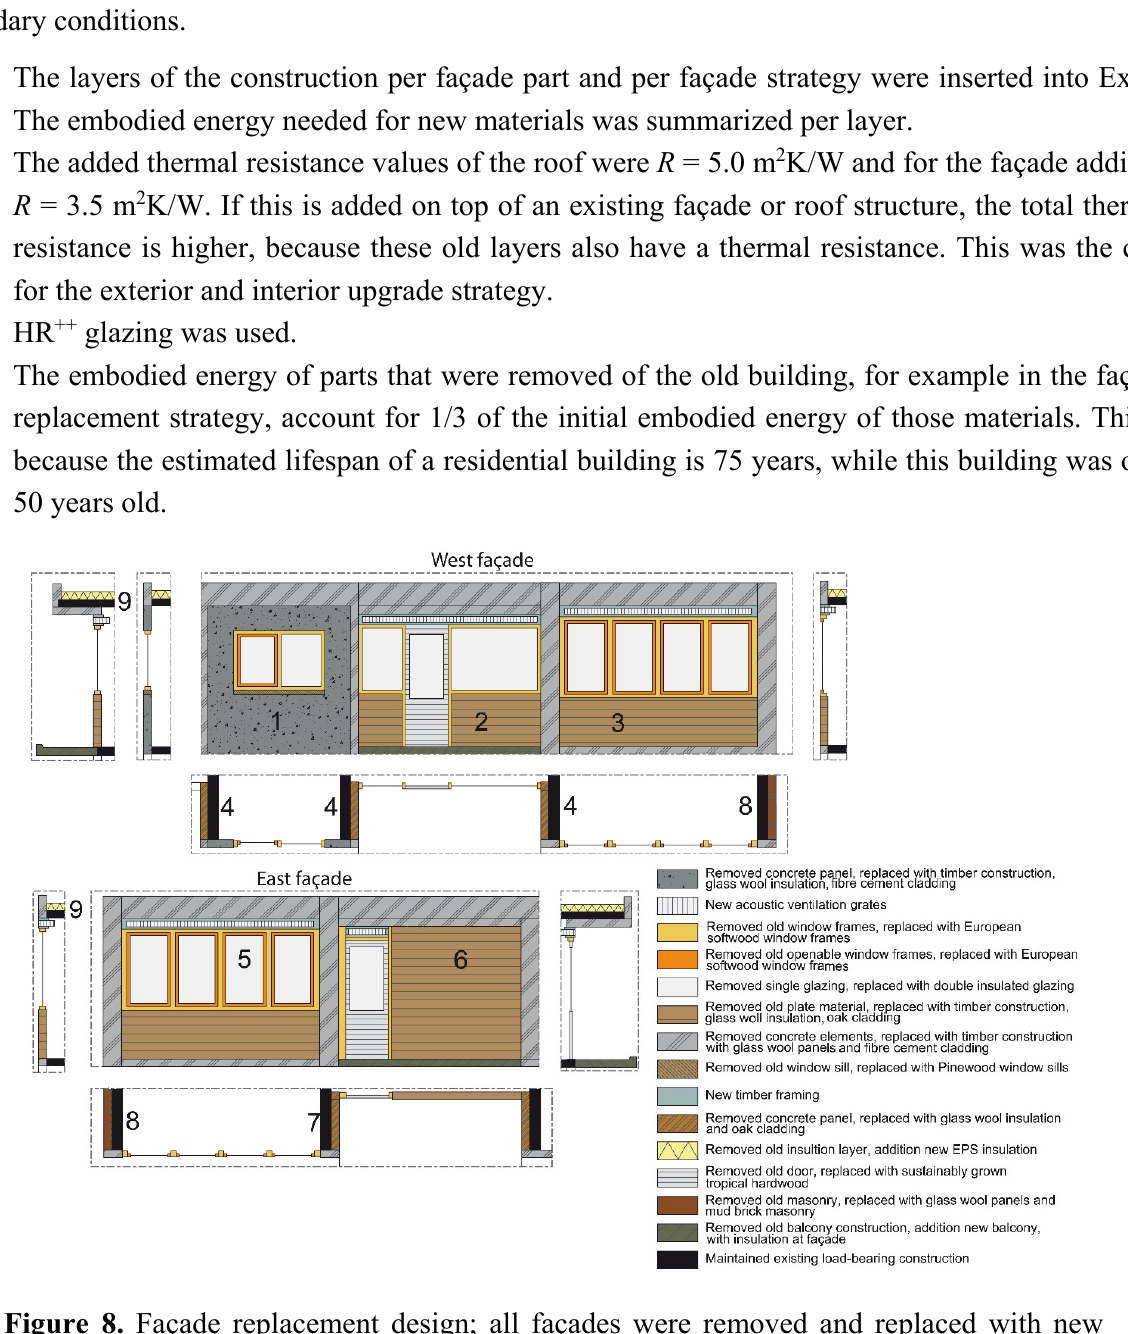
Figure 8. Façade replacement design; all façades were removed and replaced with new walls with insulation and